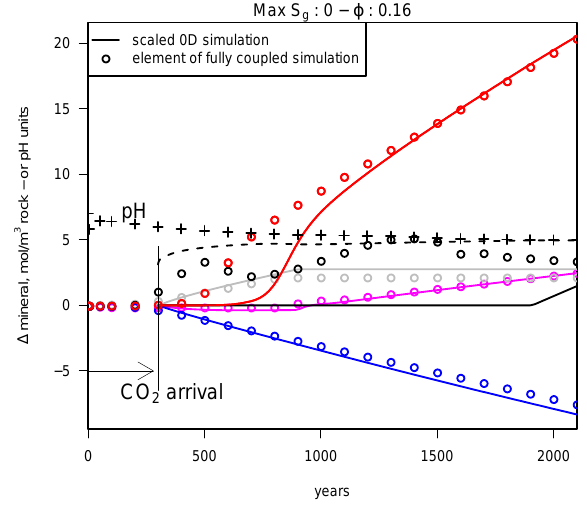
Figure 6. Comparison between the mineral changes predicted by the fully coupled simulations in one single element as opposed to the outcome of the scaled 0-D reference geochemical model. De- picted, with the same colours of Fig. 1, are siderite (red), albite (blue), chlorite (magenta) and calcite (black). Also, for complete- ness the pH in the two cases is represented (dashed line for the scaled batch and the cross symbols for the fully coupled simula- tion). The calculated similarity function for this element is 4.5.